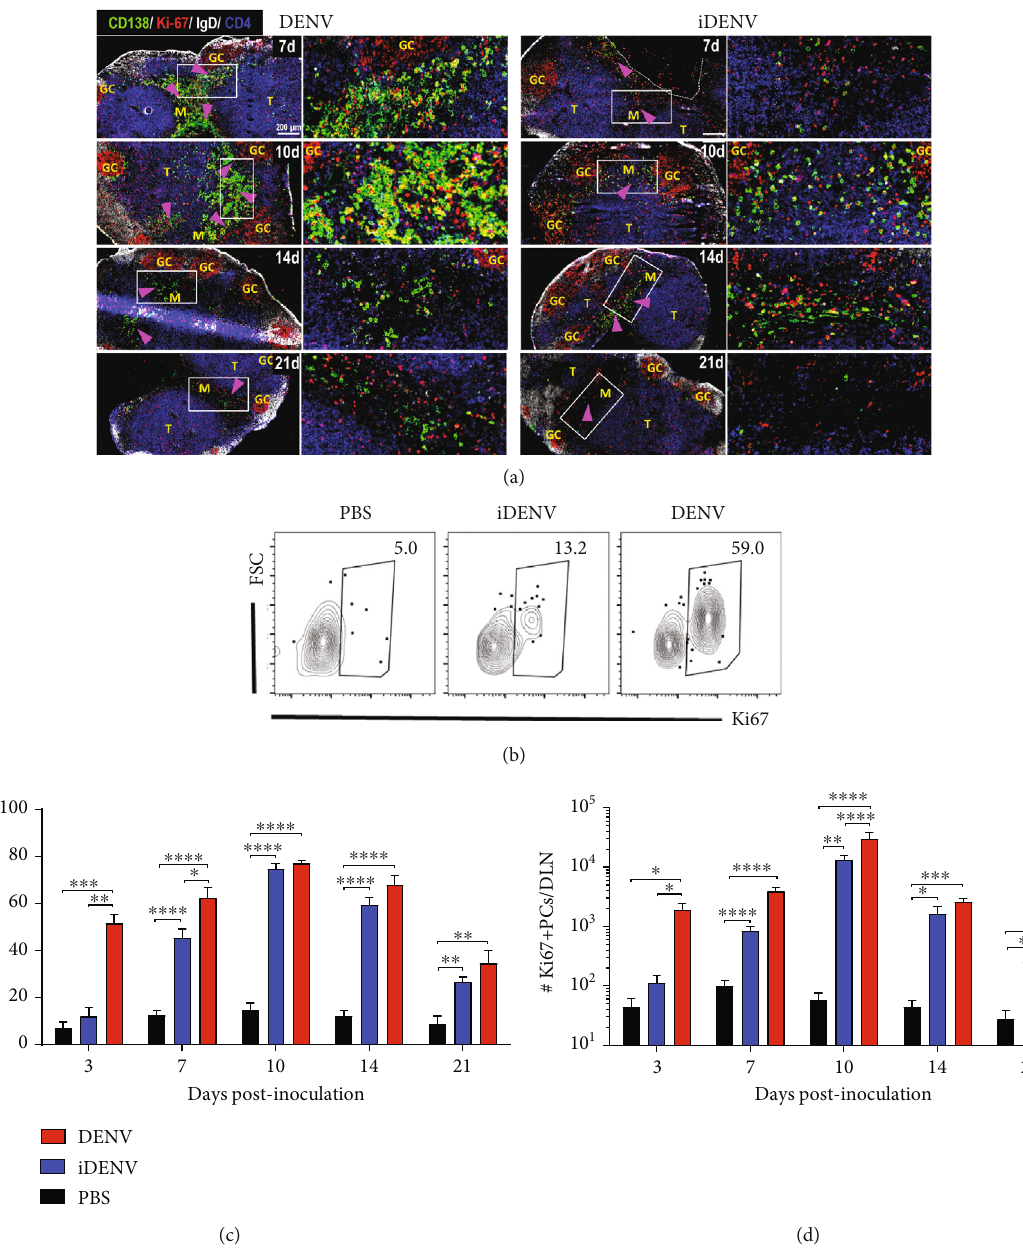
Figure 4: PC distribution and proliferative state during DENV infection. (a) DLN cryosections analyzed at days 7, 10, 14, and 21 postcutaneous inoculation with DENV (left panel) or iDENV (right panel). CD138 (green) antibody-labelled PCs, antibodies for IgD (white), and Ki-67 (red) depict GC zones and CD4 (blue) for T zone (T). Panels on the right of each group correspond to the white squares indicated on the left. PC main location is indicated with purple arrowheads for each time point. Cell suspensions from DLNs were colabelled with antibodies to surface CD138 and Ly6C and intracellularly for Ki-67. (b) Representative fl ow cytometry contour plots of proliferating Ki-67 + PCs at day 3 p.i. Kinetic of the proportion (c) and numbers (d) of Ki-67 + PCs in the DLN during the kinetic. Data shown represent the mean ± SEM and are representative of four independent experiments with two mice per group per time point and histology results from two experiments with four mice per group per time point. Two-way ANOVA with the Bonferroni post hoc test were used for the statistical analysis. ∗ P < 0 : 05 , ∗∗ P < 0 : 01 , ∗∗∗ P < 0 : 001 , and ∗∗∗∗ P < 0 : 0001